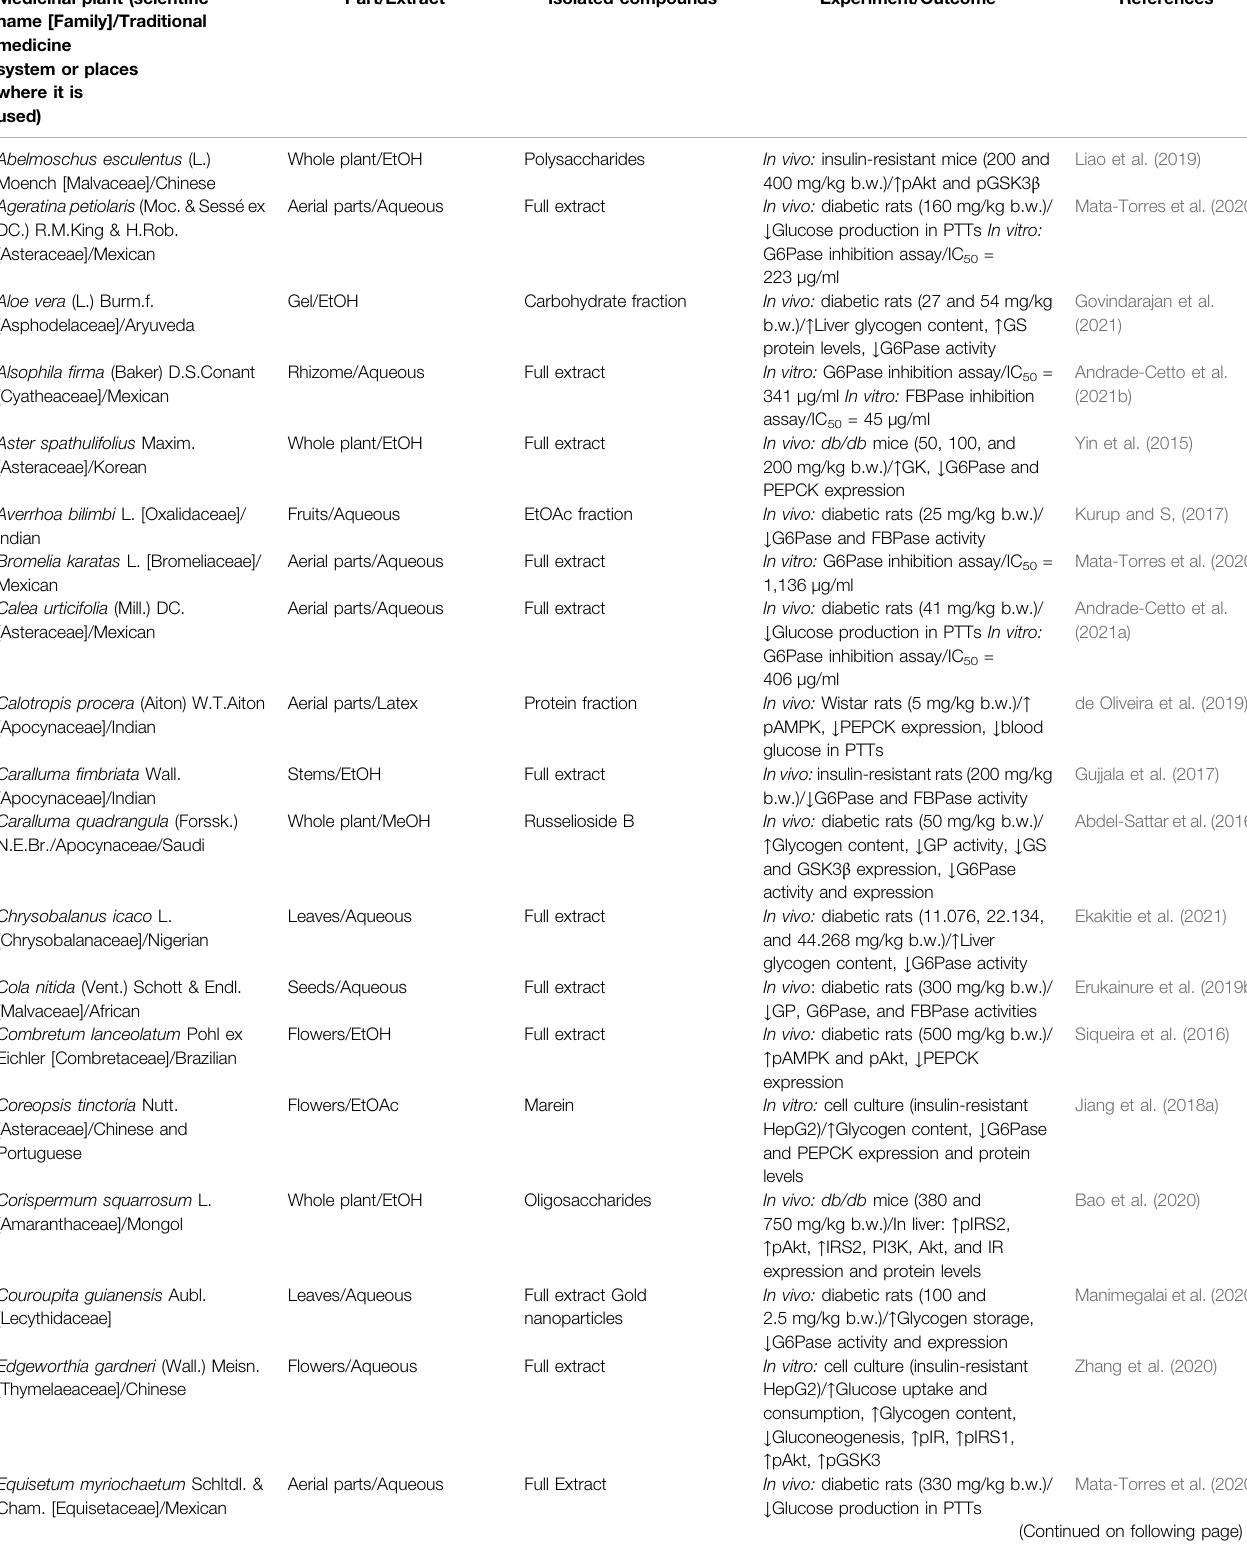
TABLE 2 | Medicinal plants and their phytochemicals capable to modulate hepatic glucose metabolism. Medicinal plant (scienti fi c name